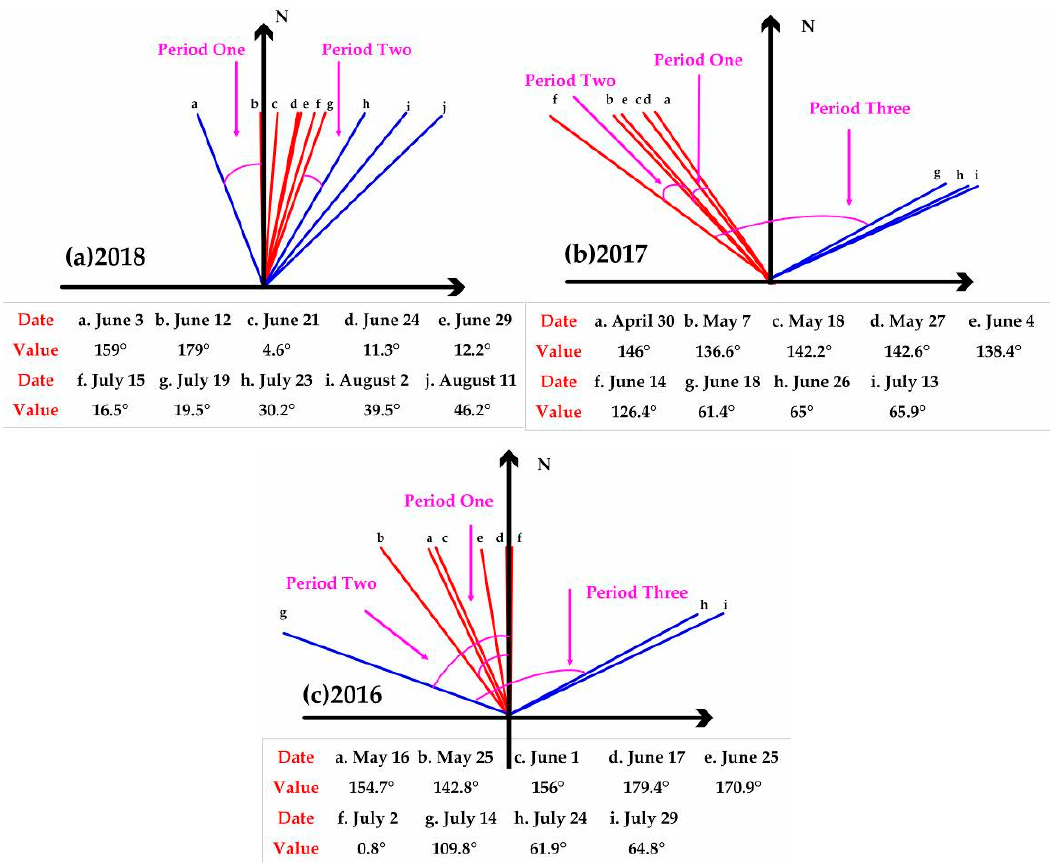
Figure 12. ( a ) Direction angle variation over time in 2018. ( b ) Direction angle variation over time in 2017. ( c ) Direction angle variation over time in 2016. The direction of the straight line (a, b, c, etc.) indicates the direction of the standard deviation ellipse on the corresponding date. Dates and values are marked on the right side of the figure. The vertical axis of the coordinate system is the north direction. Red and blue lines are used to highlight the process of abrupt angle changes, which are represented in the figure by magenta arcs.